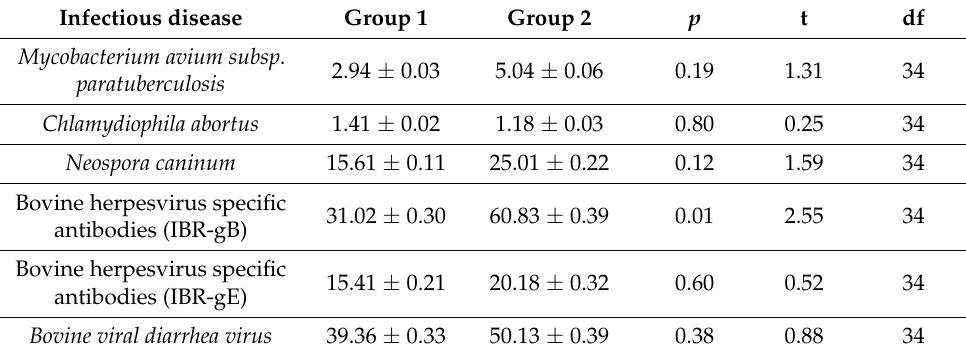
Table 1. Mean values and standard deviations ( ± SD) of Mycobacterium avium subsp. paratubercu- losis, Chlamydiophila abortus, Neospora caninum, bovine-herpesvirus-specific antibodies (IBR-gB and IBR-gE), and bovine viral diarrhea virus expressed as percentages obtained from both groups along with statistical results of the unpaired t